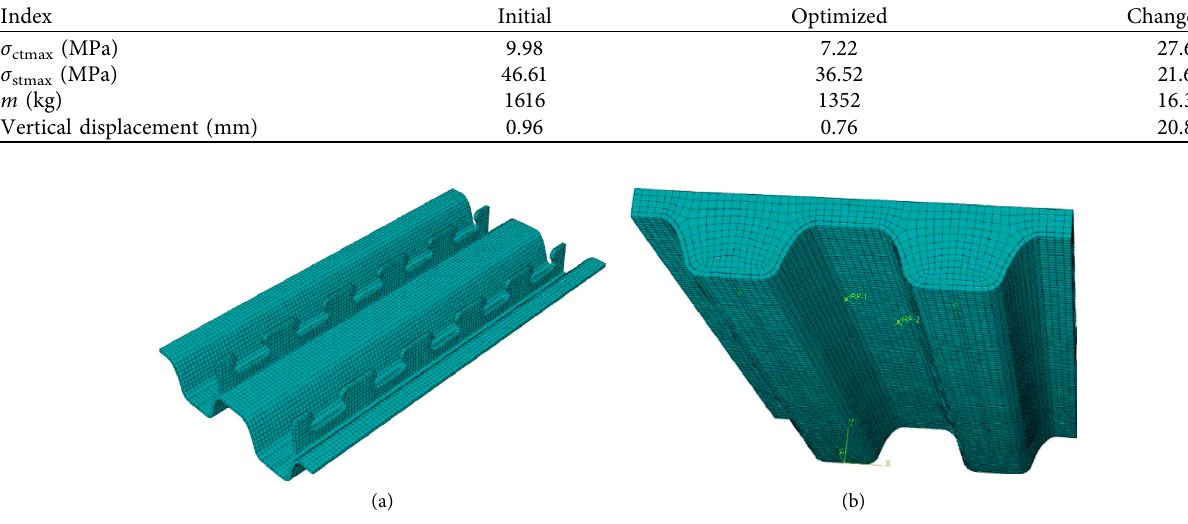
Table 5: The mechanical performance of the initial and optimized composite bridge